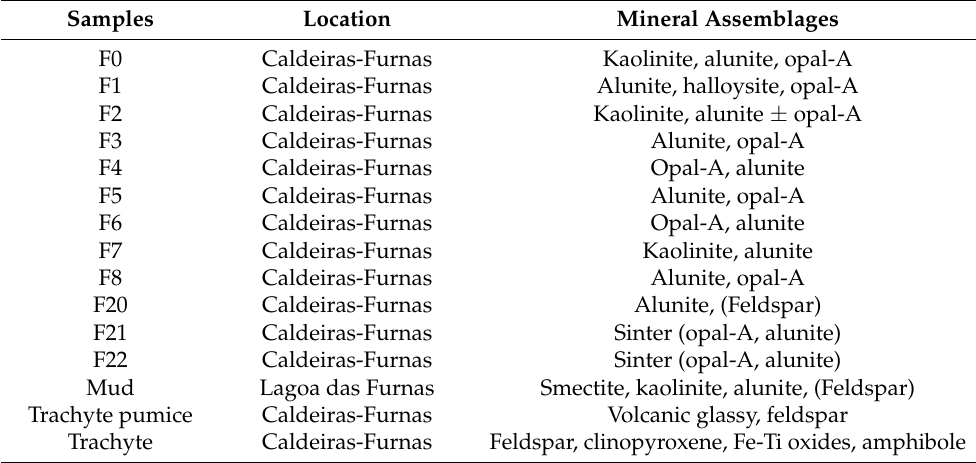
Table 1. Mineral assemblages of the analysed samples by